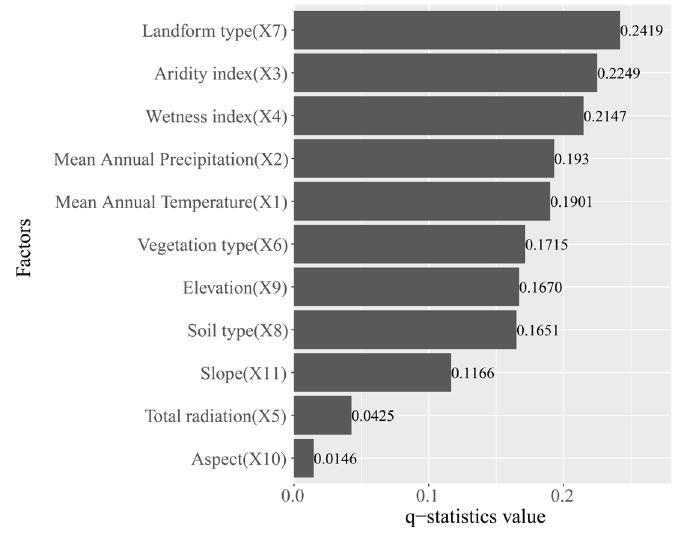
Figure 11. Factor detection of environmental factors on NDVI change.